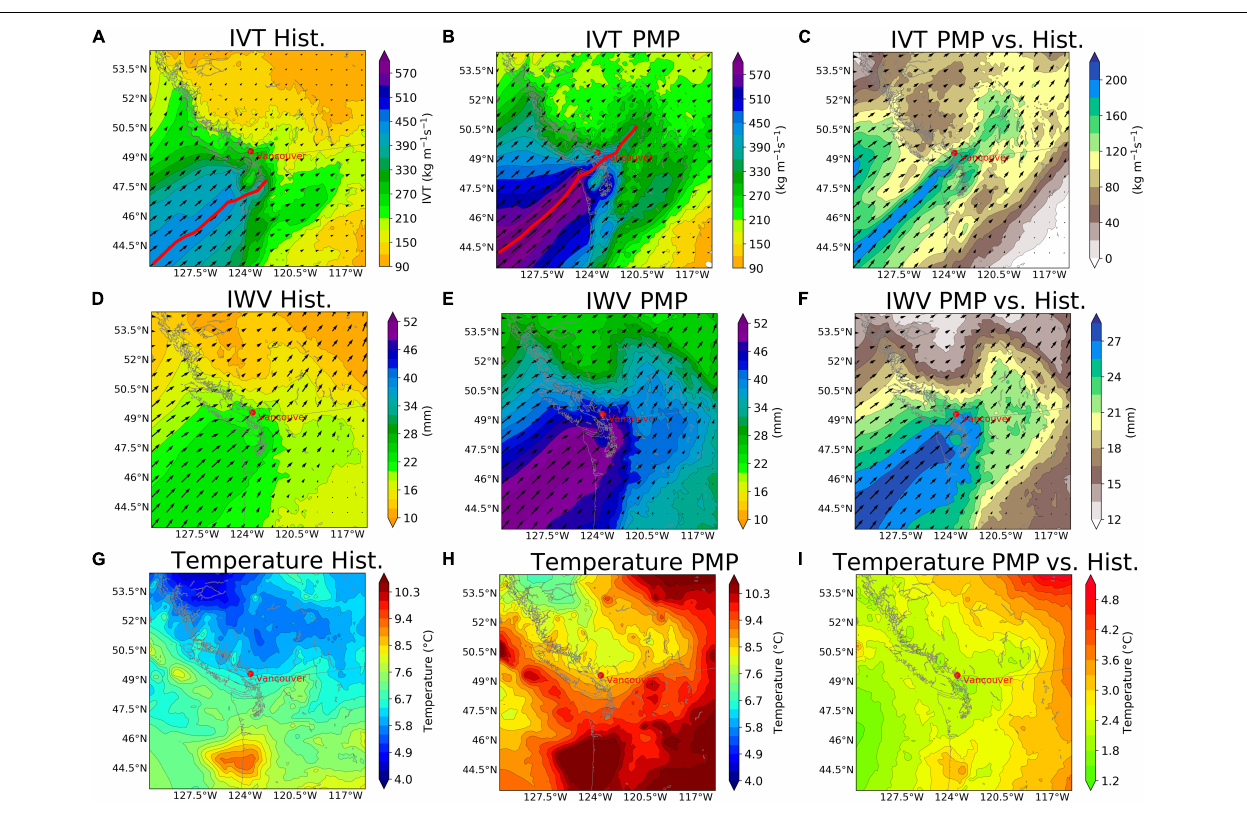
FIGURE 8 | The simulated large-scale environmental fields when the maximum 72-h precipitation occurred during the simulated events, including IVT (A–C) , IWV (D–F) and the pressure-weighted vertically averaged temperature between 850 and 1000 hPa (G–I) from the 10-km simulations, including the simulated